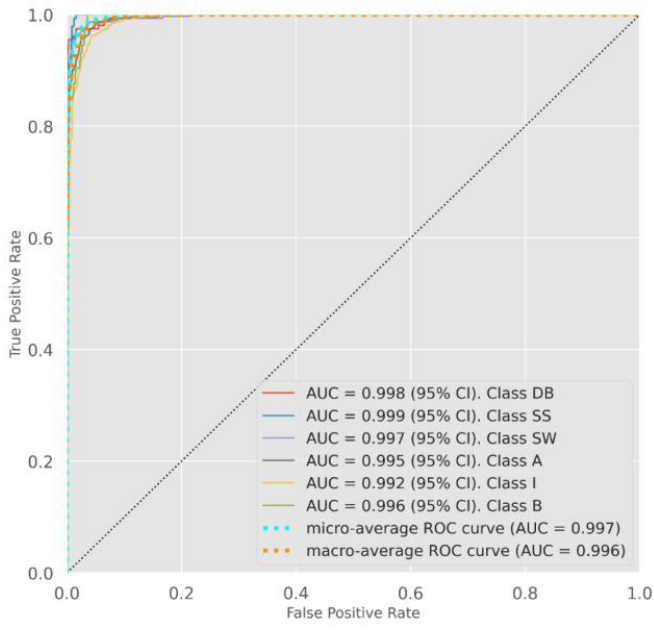
Figure 12. ROC curves of XGBoost classifier for six classes (‘DB’, ‘SS’, ‘SW’, ‘A’, ‘I’, ‘B’).